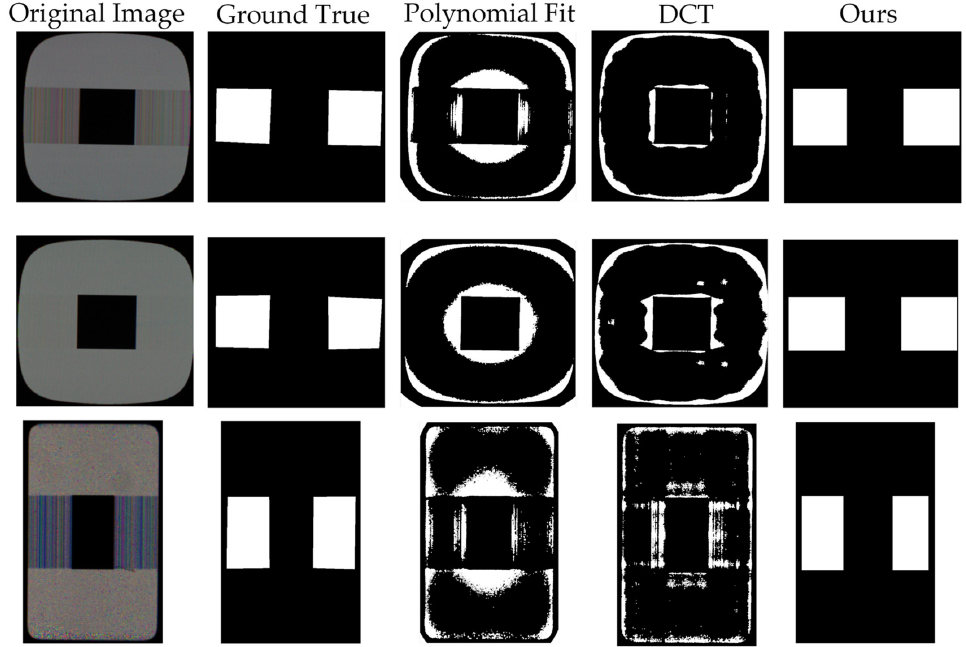
Figure 8. Crosstalk defect detection results from different methods.